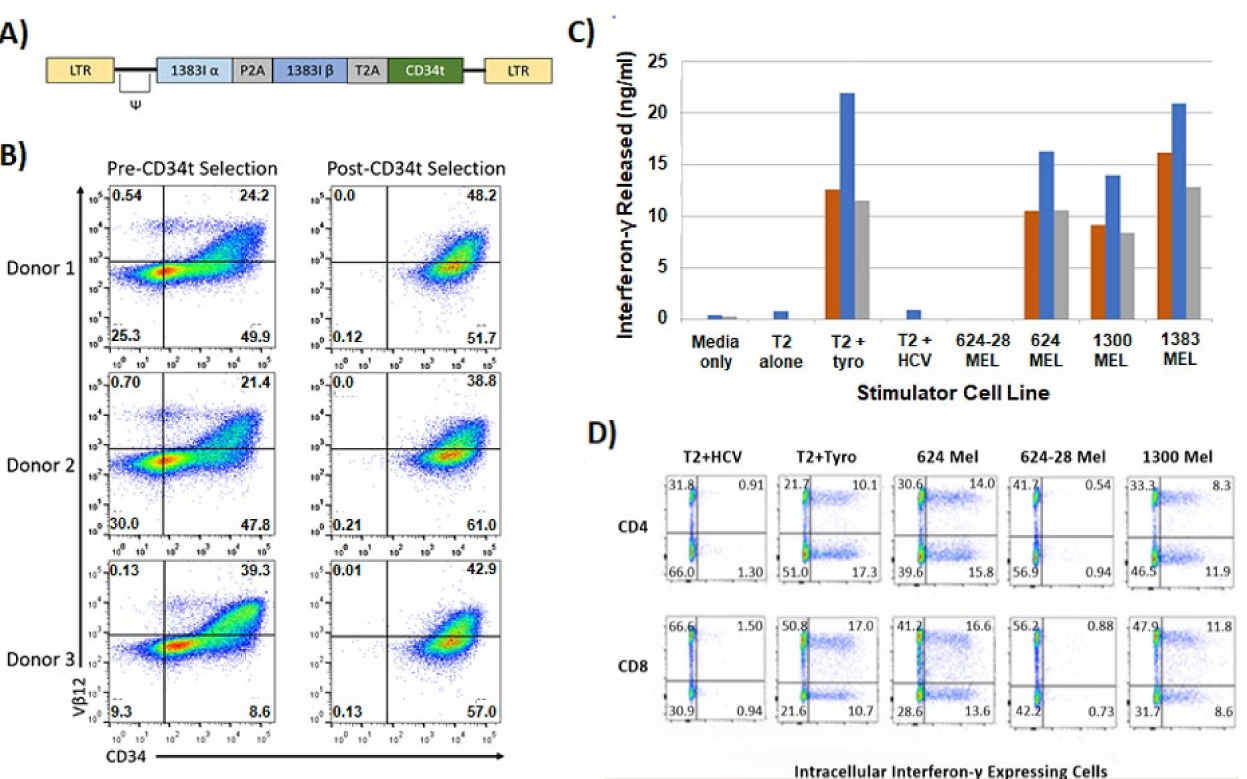
Figure 4. Transduction, expression, and function of TIL 1383I TCR transduced human T cells. We